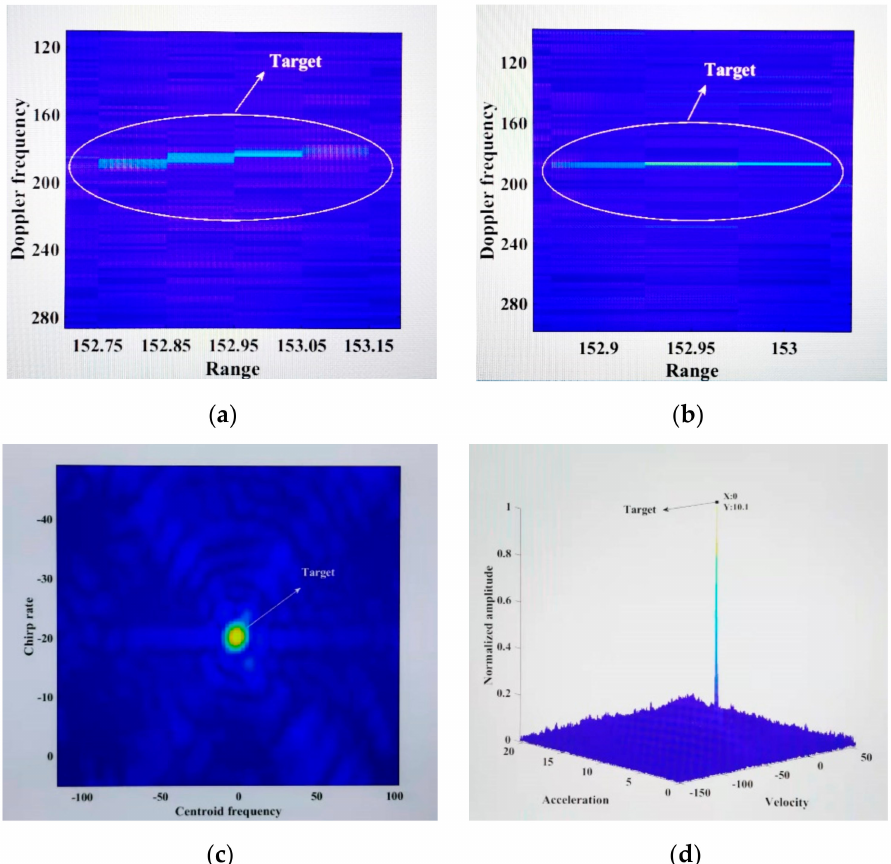
Figure 7. Real data processing results: ( a ) Result of MTD; ( b ) Result after LRM correction; ( c ) Result after QRM correction and LVD; ( d ) Result of coherent integration in velocity-acceleration